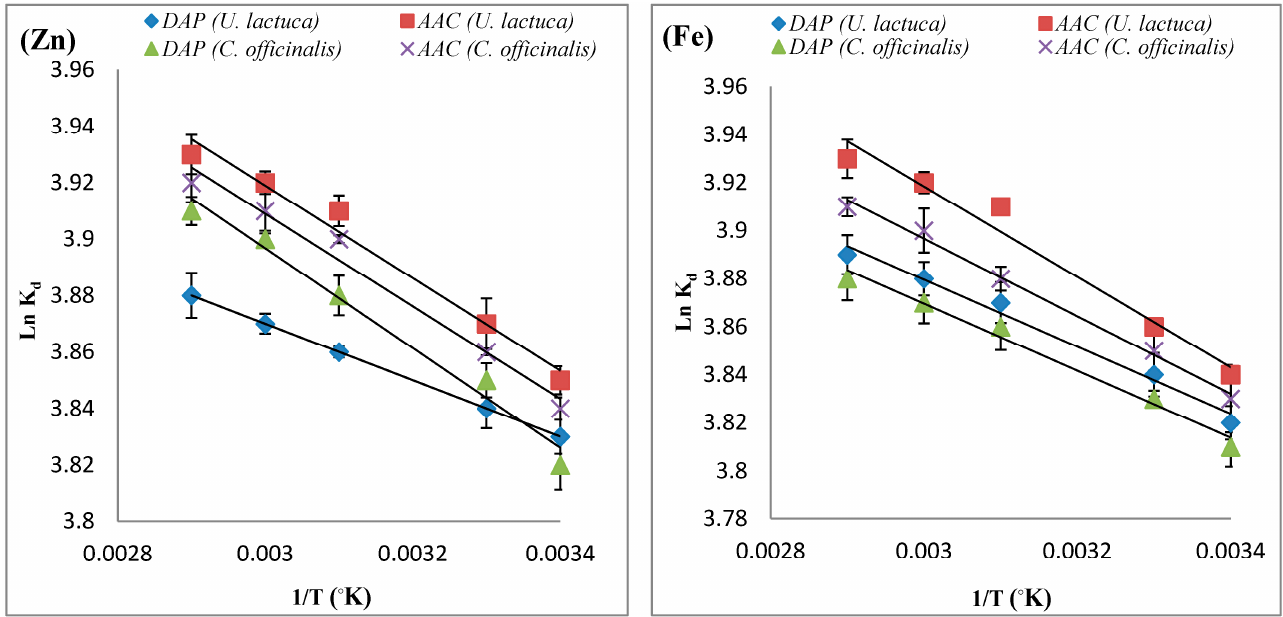
Figure 5. Effect of temperature on the percentage of removal of Zn +2 and Fe +3 (at 120 min., pH 5.0 by using 50 mg.L − 1 metal- ion concentration and 1.0 g.L − 1 ) using dried algal powder (DAP) and the activated carbon (AAC) of both U. lactuca and C. officinalis. Each data point represents the mean ± SD.